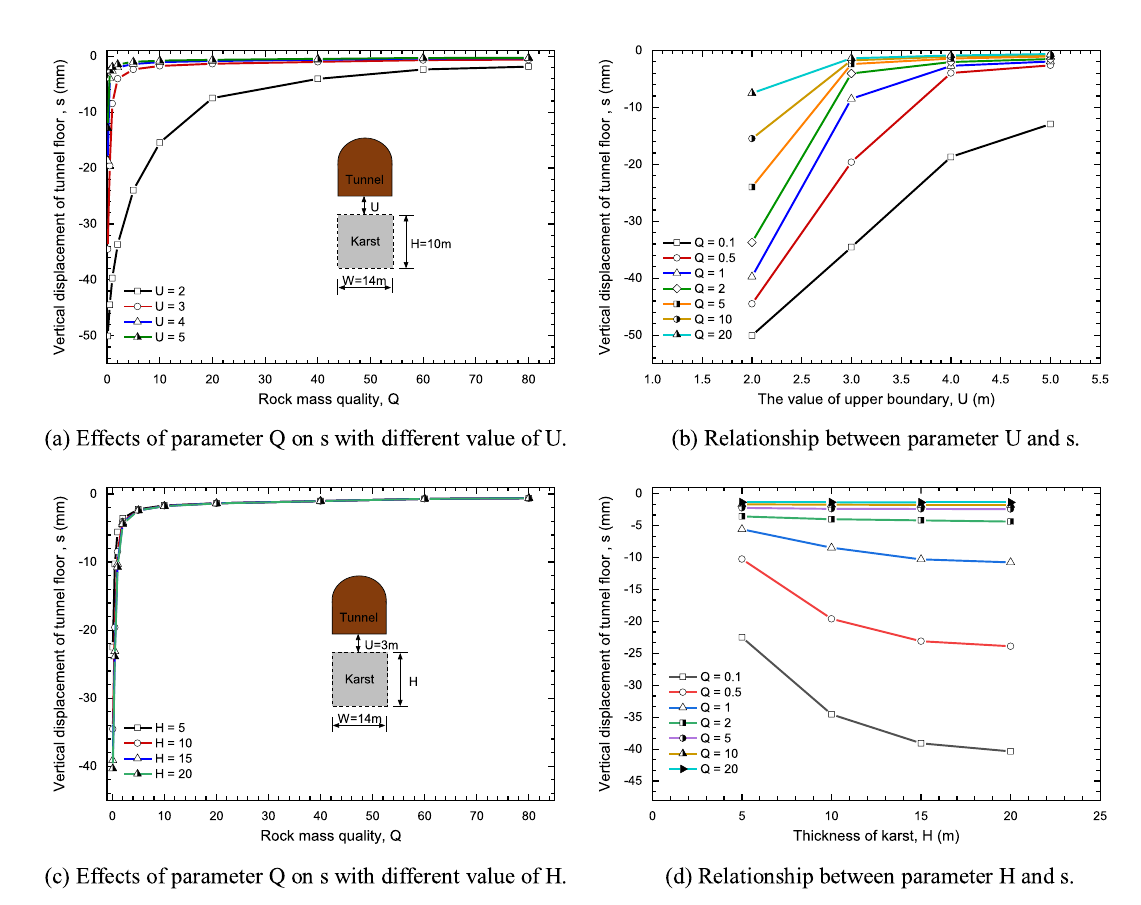
Figure 16. The Effects of rock mass quality Q on the maximum settlement of tunnel